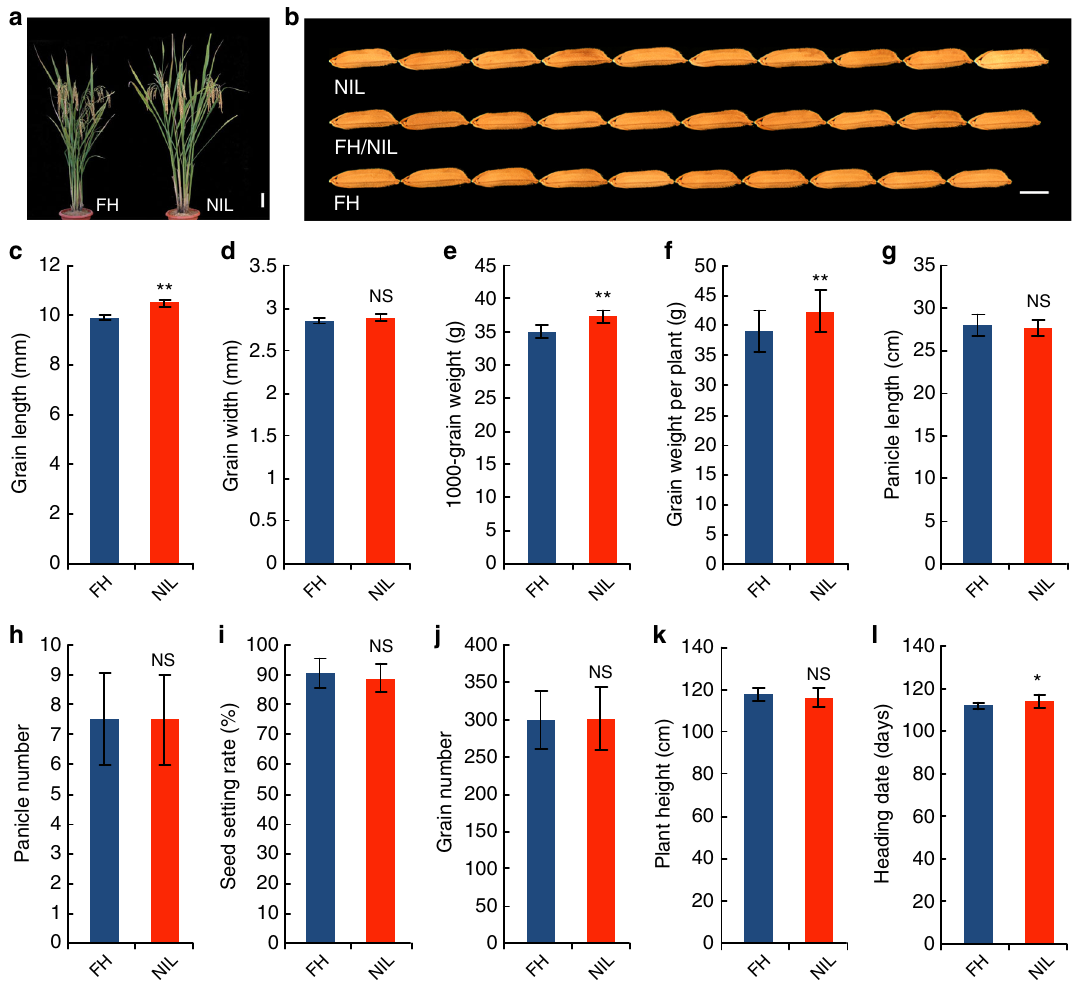
Fig. 4 A yield-related traits of FH and NIL-FH: GW3p6 . a Plant phenotype of FH and NIL-FH:: GW3p6 . Scale bar, 10 cm. b Grain morphology of FH, NIL-FH: GW3p6 and FH/ NIL-FH:: GW3p6 . NIL and FH represent the grain morphology of NIL-FH:: GW3p6 and FH, respectively. FH/NIL indicates the grain morphology of plants with heterozygous OsMADS1 ( OsMADS1/OsAMDS1 GW3p6 ) genotype. Scale bar, 5 mm. c – l A fi eld-based comparison of the FH and NIL-FH:: GW3p6 plants. c Grain length, d grain width, e 1000-grain weight, f grain yield per plant, g panicle length, h panicle number, i seed-setting rate, j grain number per panicle, k plant height, and l heading date. Data are shown as means ± SD ( n = 24) with the indicated signi fi cance from a two-tailed Student ’ s t test. For statistical signi fi cance, * p < 0.05, ** p < 0.01, NS not signi fi cant. Source data of Fig. 4c – l are provided as a Source Data fi